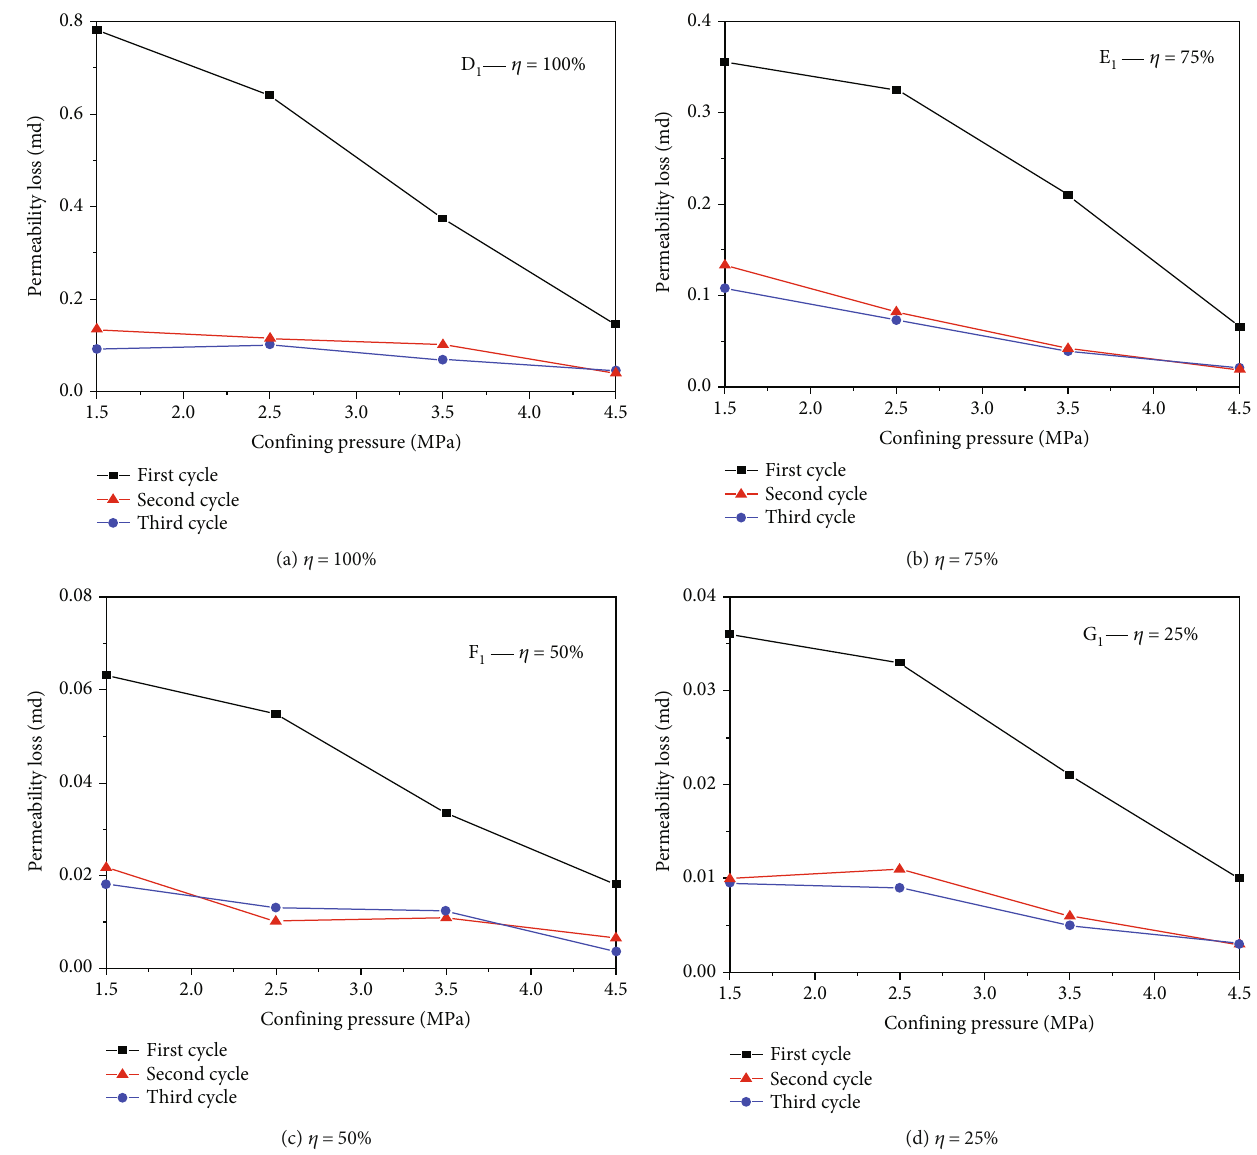
Figure 7: Relationship between permeability loss and con fi ning pressure. Table 2: Ratio of permeability loss during di ff erent cycle stages.